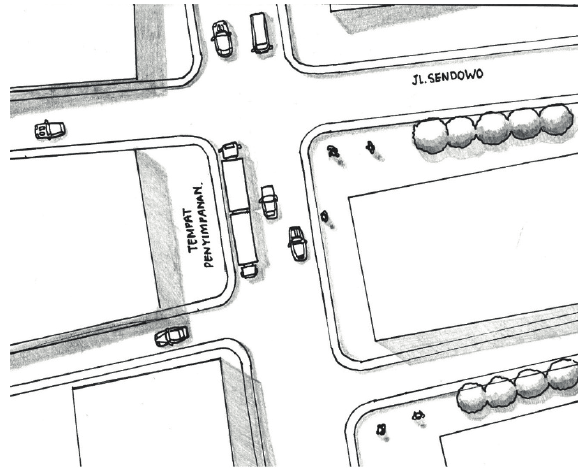
Fig. 9. The Bird View of the Situation at Kepodang Street, Kota Lama Semarang Where There are many Activities